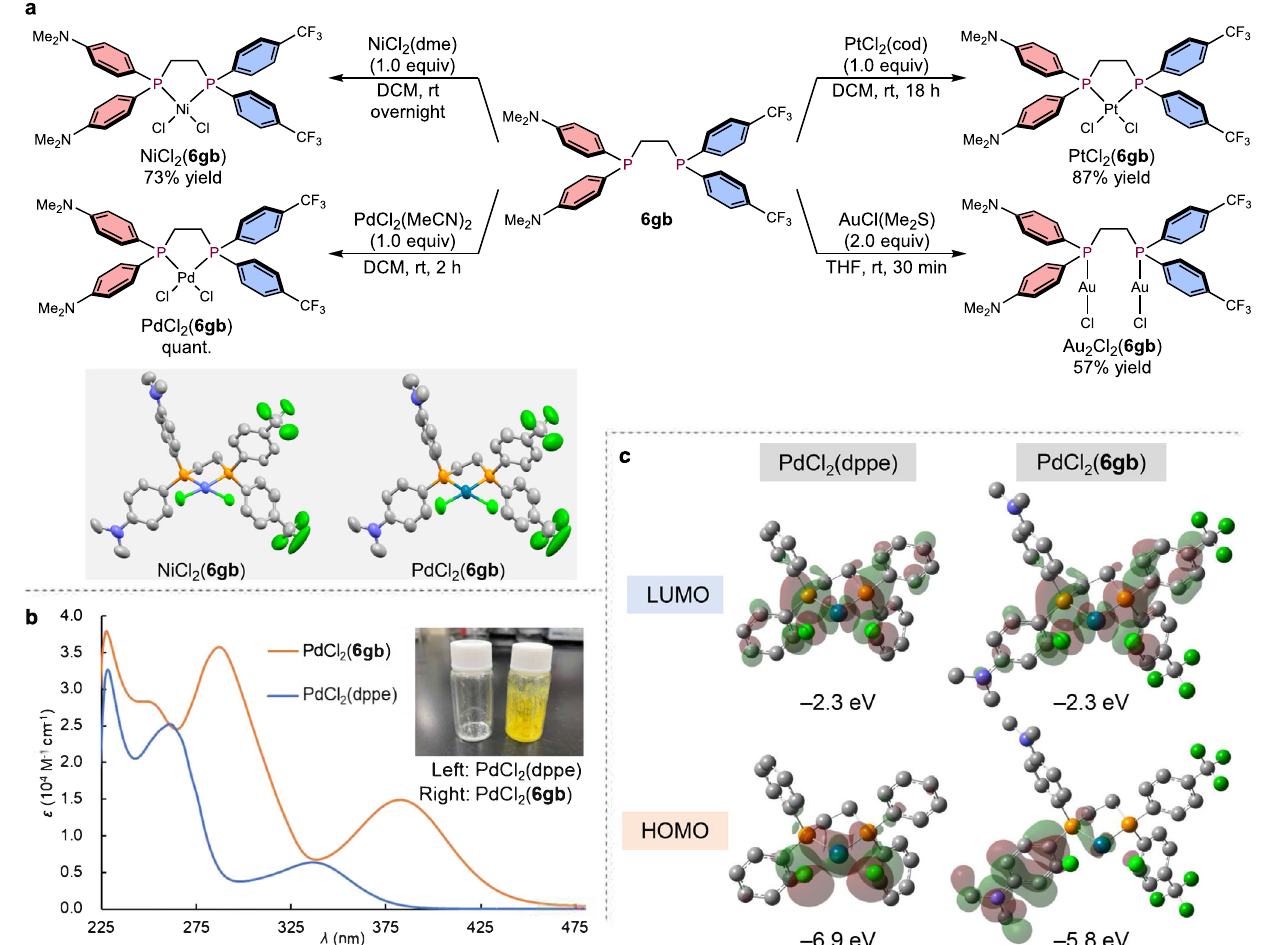
Fig. 8 | Synthesis of transition-metal complexes and physical properties. a Synthetic application of the unsymmetric DPPE derivatives. dme: 1,2-dimethox- yethane, cod: cycloocta-1,5-diene b Absorption spectra of Pd complexes PdCl 2 ( 6gb )(5×10 − 5 M)andPdCl 2 (dppe)(6×10 − 5 M)inDCM. c HOMOsand LUMOs